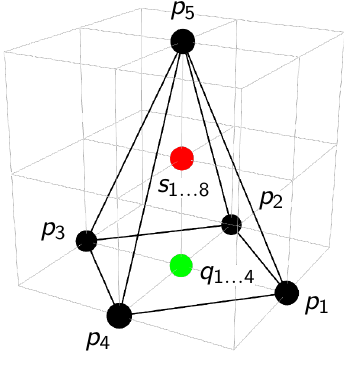
Figure 7 . Toric diagram of Y 2 , 0 ( CP 1 × CP 1 )